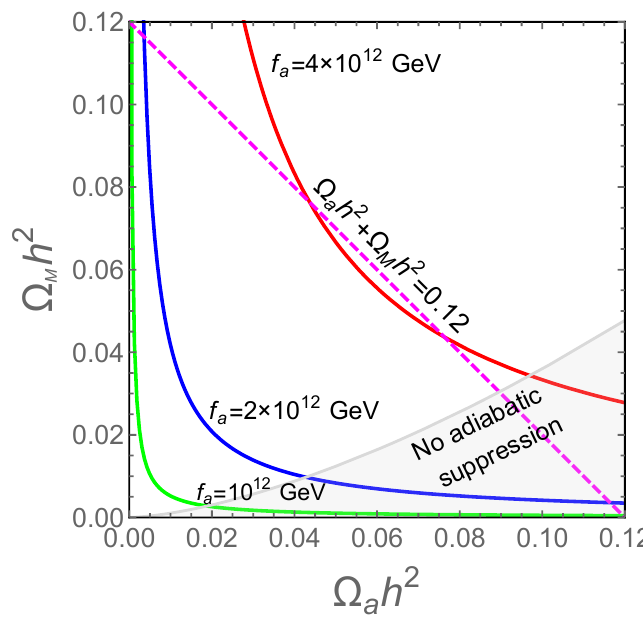
Figure 2 . Relation between the axion and monopole abundances. We take f a = 1 (cid:2) 10 12 GeV 3 (green curve), 2 (cid:2) 10 12 GeV (blue curve), and 4 (cid:2) 10 12 GeV (red curve). We assume (cid:18) ini ; H = 1, (cid:11) H = 1, and N DW = N a;H . The diagonal (magenta) dashed line represents the observed DM abundance. In the light-gray shaded region, the adiabatic suppression does not work and the results should not be